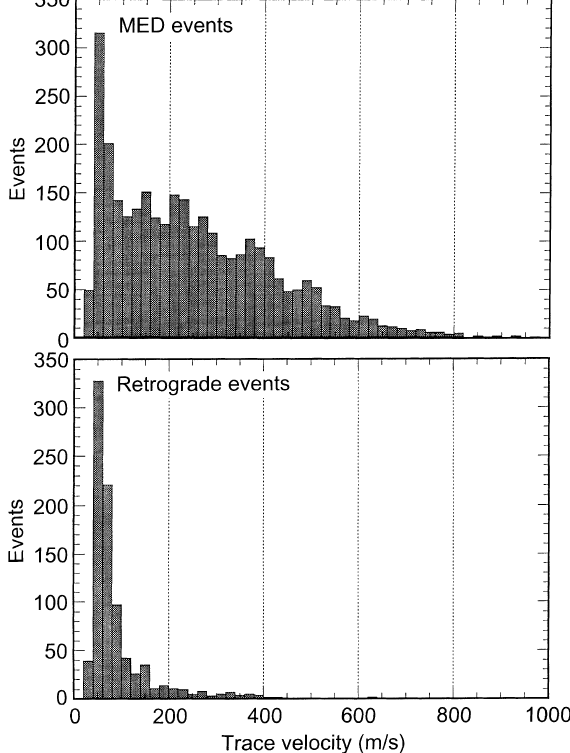
Fig. 14. Histograms of ( top ) MED events measured trace speed and ( bottom ) retrograde events ( (cid:135) 90 (cid:14) to B shadow) measured trace speed. It is most obvious that the retrograde events move more slowly across the VLA plane